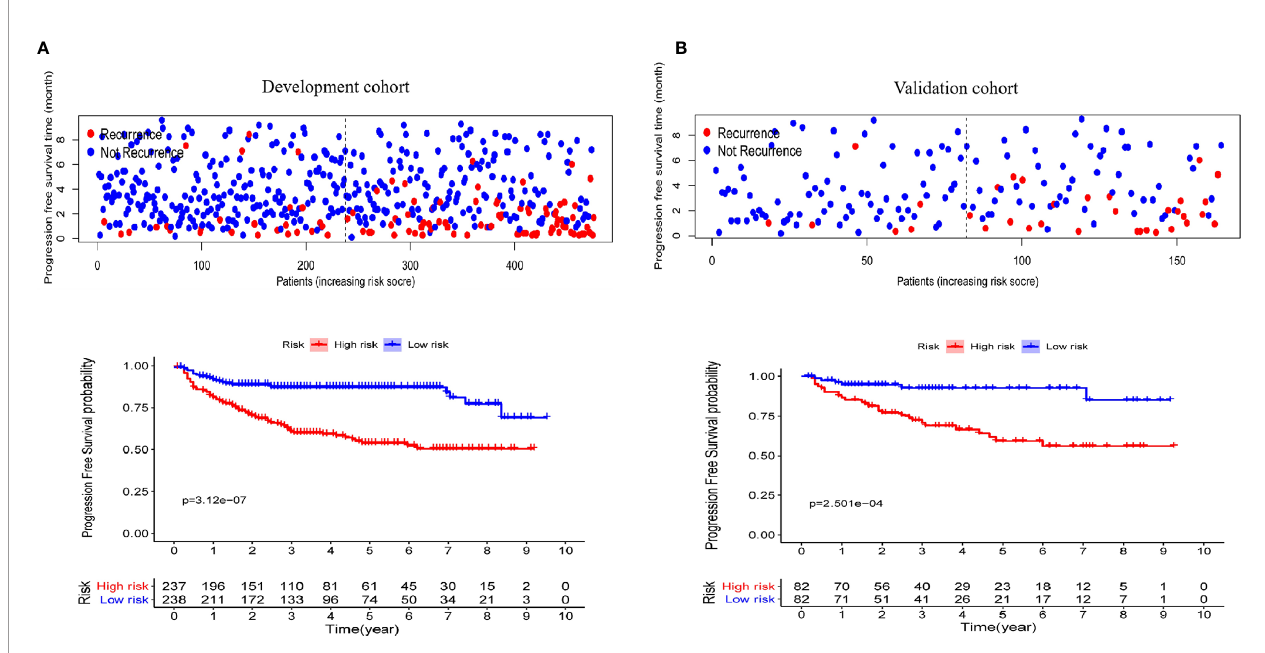
FIGURE 7 | The KM curves for high-risk group (red) and low-risk group (blue) in the development (A) and validation cohort (B) .